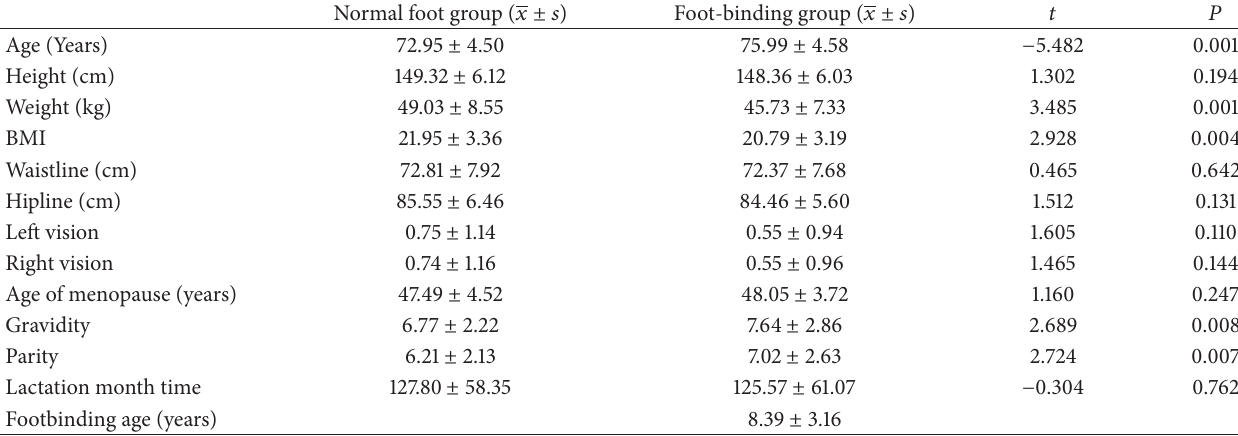
Table 1: General health indicators of normal foot group ( 𝑛 = 104 ) and foot-binding group ( 𝑛 = 204 ).